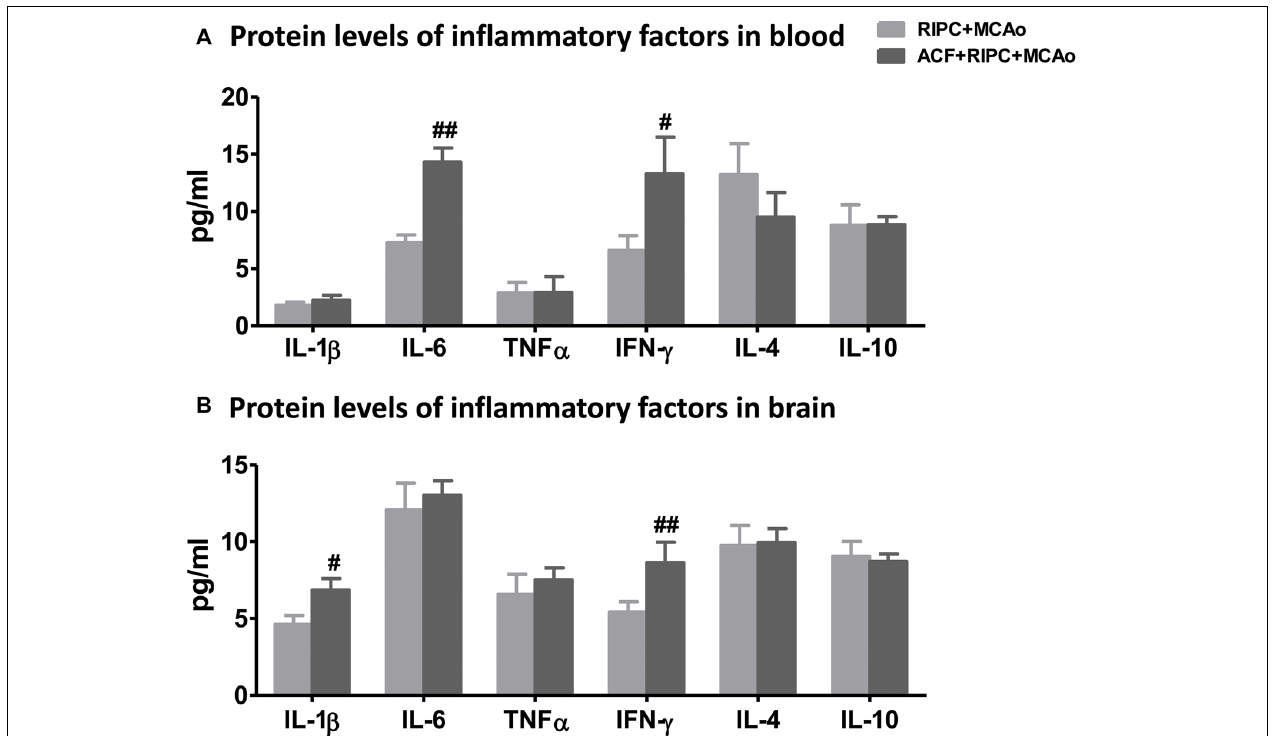
FIGURE 5 | The effect of ACF on protein levels of inflammatory cytokines in aged stroke animals receiving RIPC. (A) Protein levels of the pro-inflammatory cytokines IL-1 β , IL-6, TNF α and IFN- γ and anti-inflammatory cytokines IL-4 and IL-10 in the peripheral blood, respectively in RIPC+MCAo and ACF+RIPC+MCAo group in